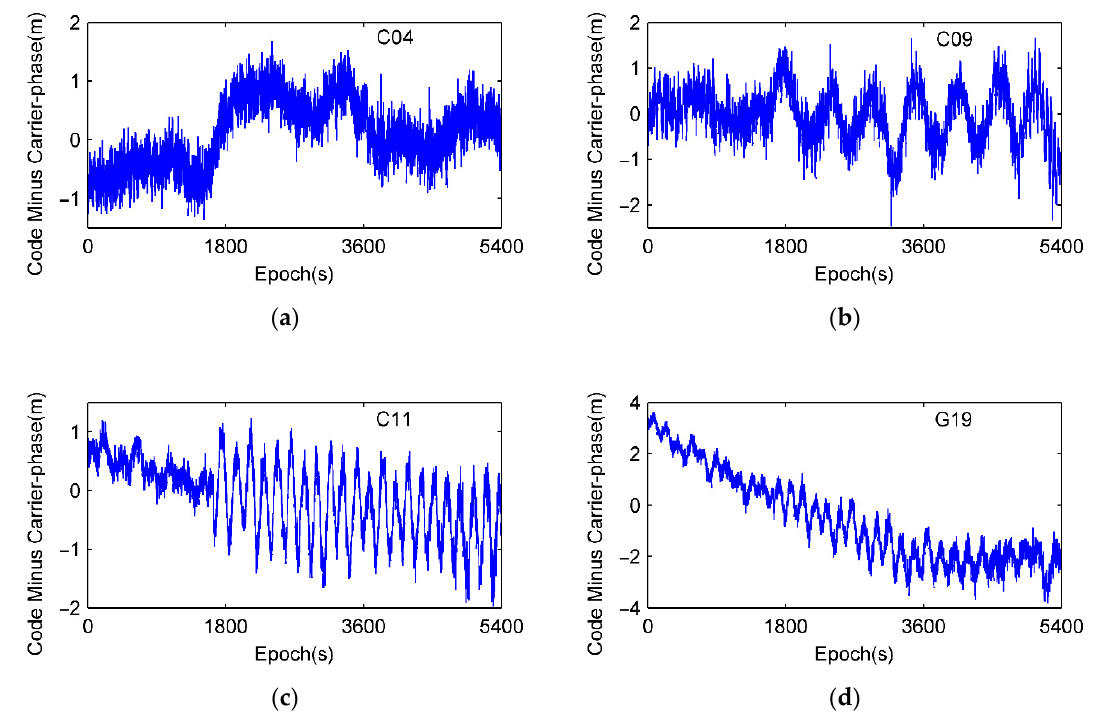
Figure 6. Code minus carrier on DOY 310. ( a ) C04, ( b ) C09, ( c ) C11, and ( d ) G19.